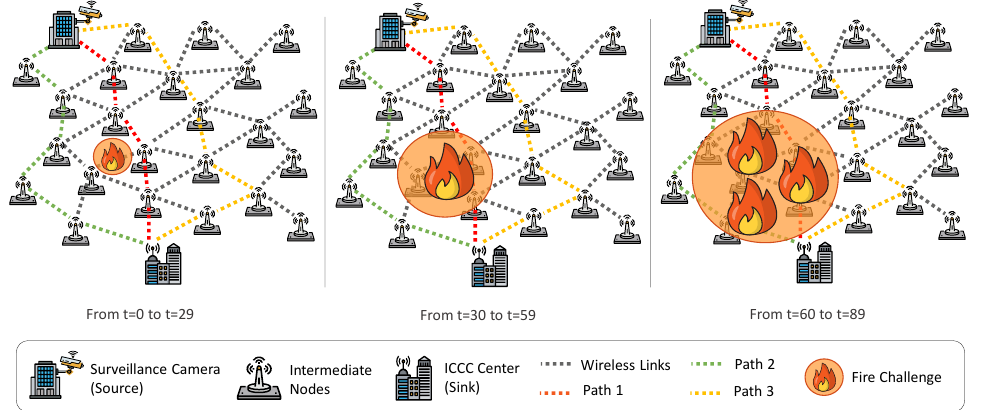
Figure 9. Fire challenge scenario.